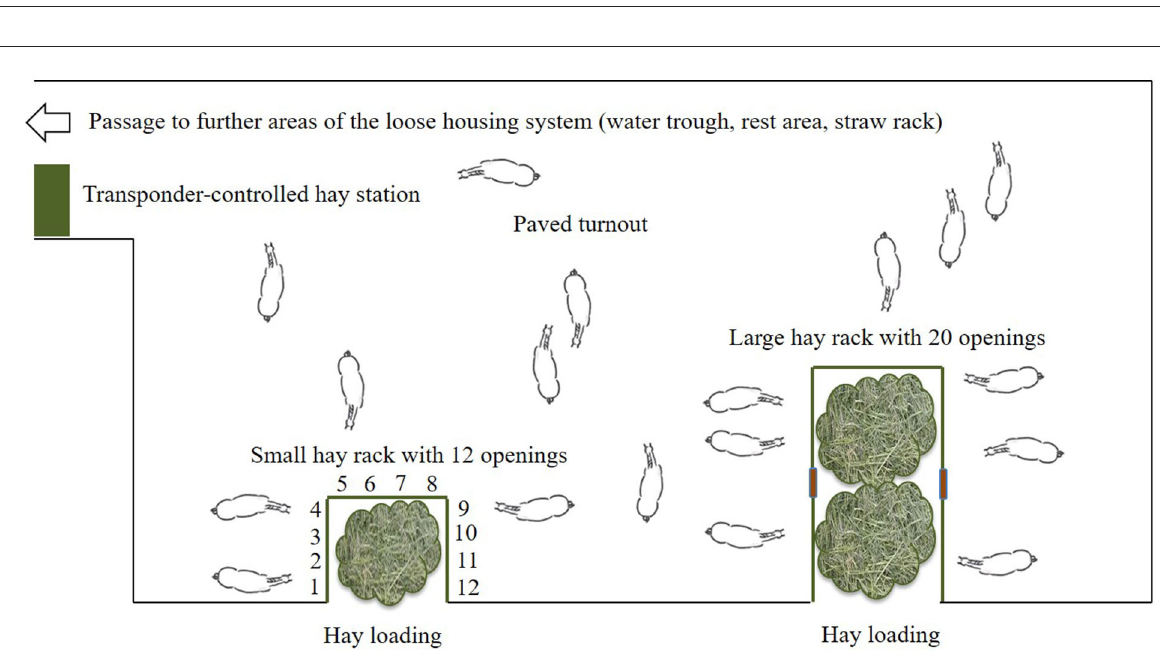
FIGURE2 Sketch of the experimental area in the loose housing system (open horse stable with permanent access to a turnout area) with a total of 32 feed-throughs (openings) at two time-controlled hay racks ( ©